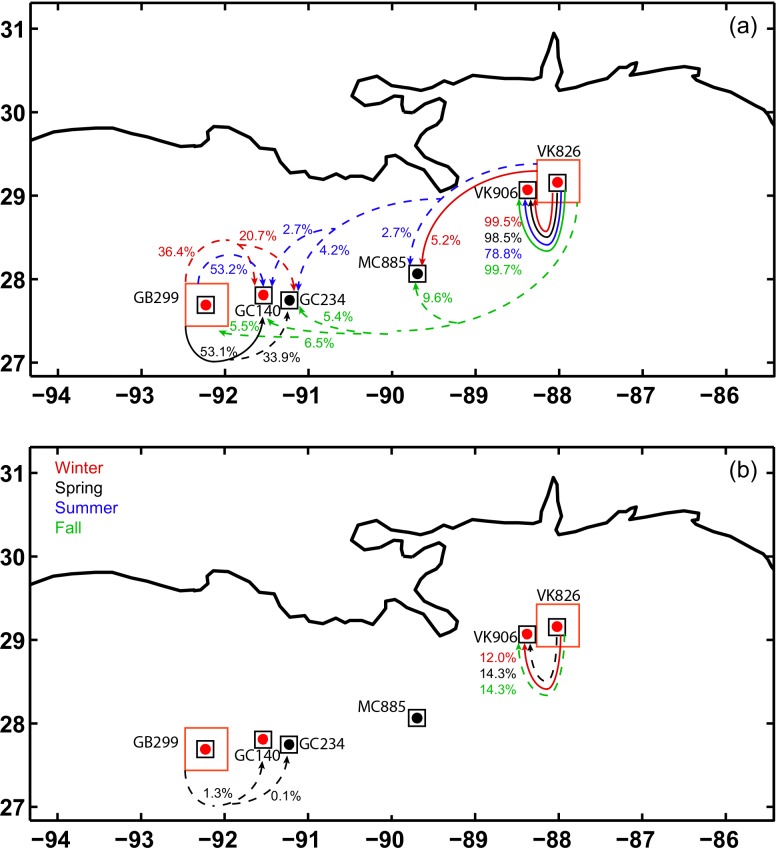
Connectivity diagrams VK826 and GB299.Connectivity diagram for larvae released at VK826 and GB299. (a) No mortality term included. (b) Maximum competency period PLD = 20 days. Solid lines: Locations connected in all years (2010, 2011 and 2012). Dash lines: Locations connected in one or two years. Color indicates season. The percentage marked next to each arrow corresponds to the % of particles that reach the connected site.